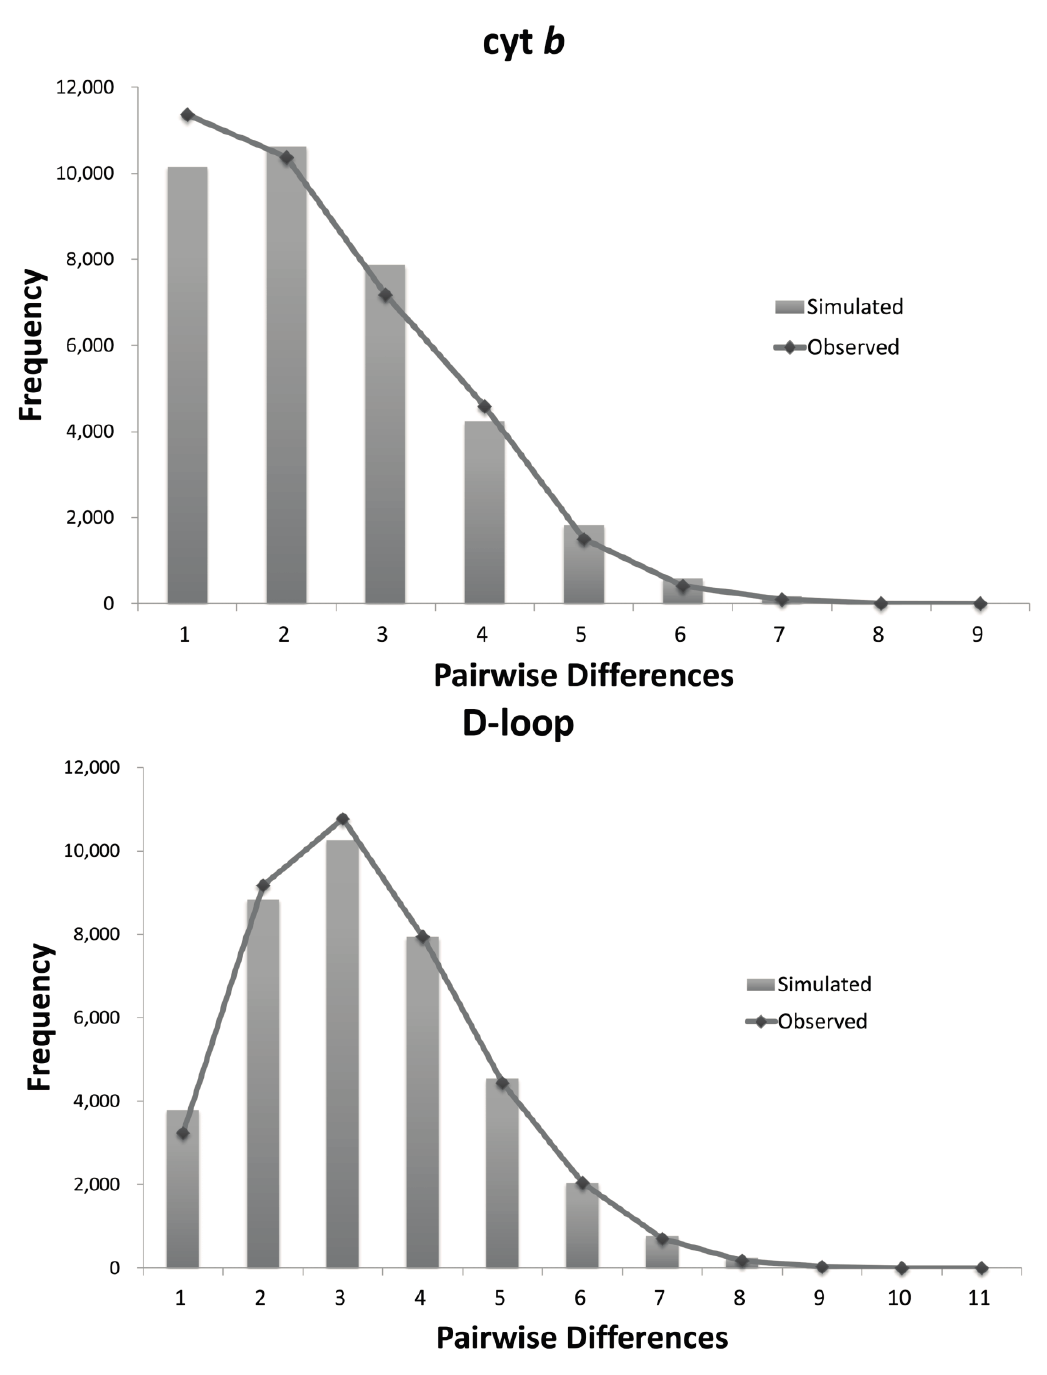
Figure 1. Mismatch distribution analyses of Cirrhimuraena chinensis Kaup for cyt b , CR and concatenated sequences (cyt b +